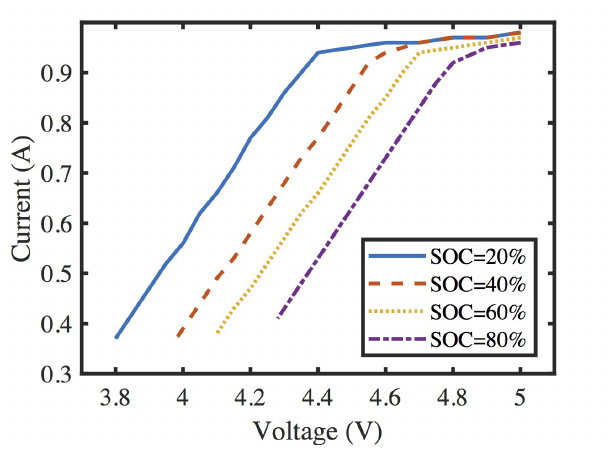
Figure 6. Portable battery charging voltage and current characteristics measured at different state of charge (SOC)